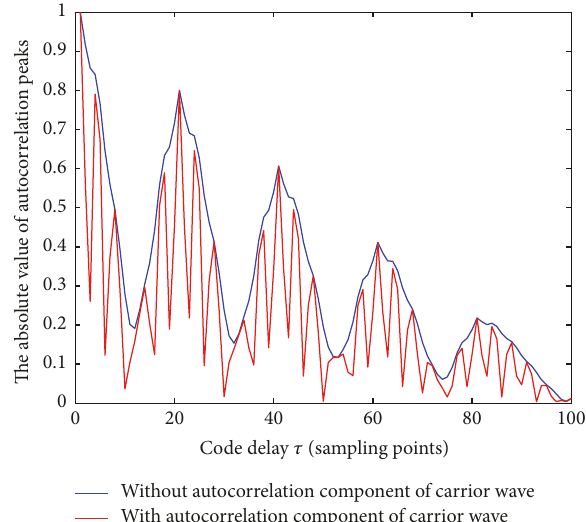
Figure 7: The absolute value of the autocorrelation peaks with SNR = 10dB.